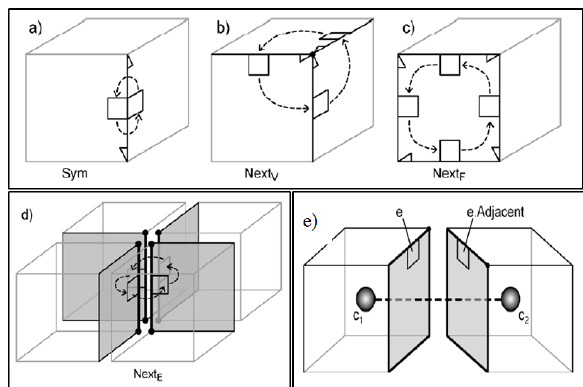
Fig. 7. Navigation of Dual Half Edge (Boguslawski, 2011).